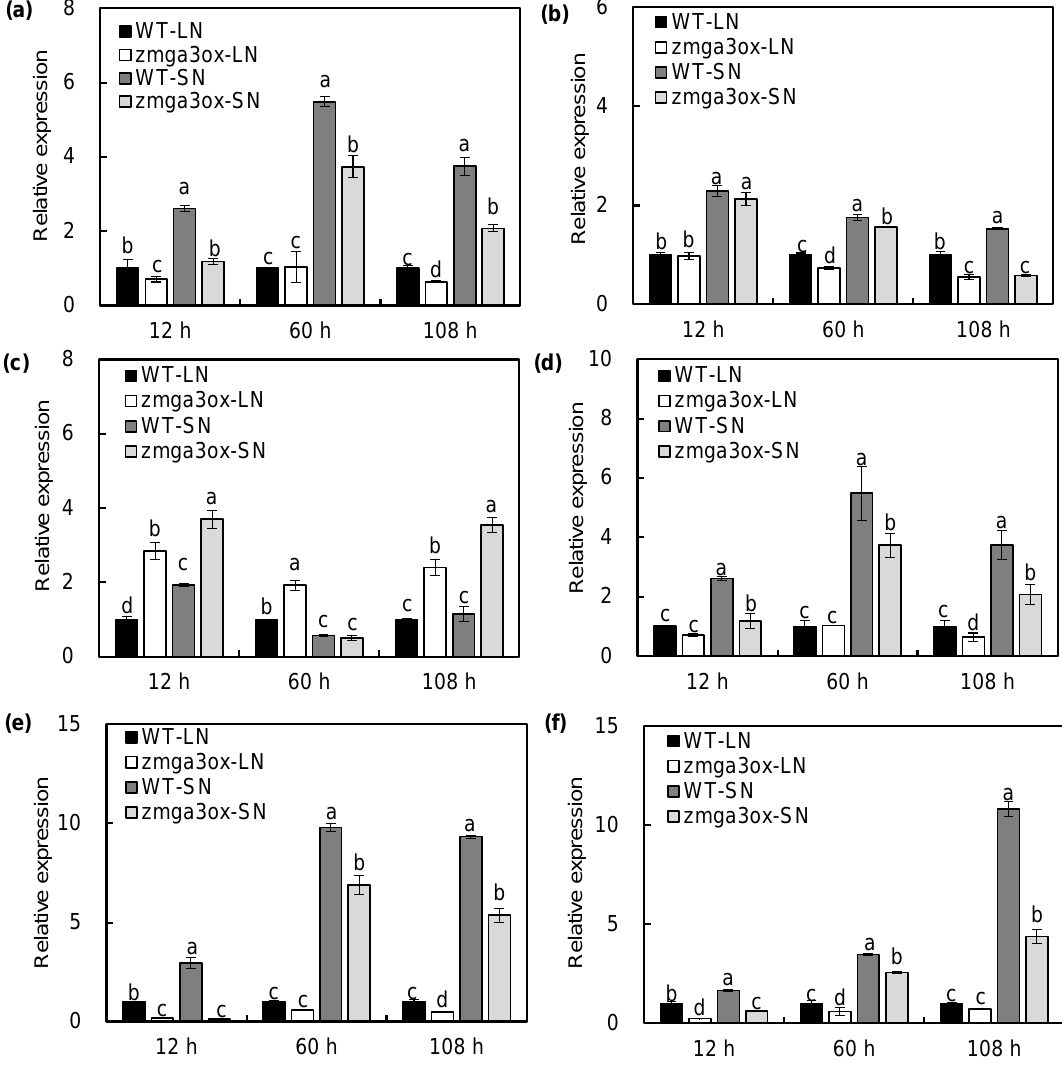
Figure 9. The expression levels of ZmTCP33 ( a ), ZmLBD24 ( b ), ZmBbZIP160 ( c ), ZmWRKY34 ( d ), ZmEREB93 ( e ), and ZmMYB41 ( f ) in wild-type and zmga3ox roots under LN and SN conditions. Roots were harvested at 12, 60, and 108 h after LN and SN treatments. Values were the means ± SD ( n = 3). Different letters indicated significant difference between the wild-type and zmga3ox plants at the same time point calculated by Fisher’s LSD ( p < 0.05).